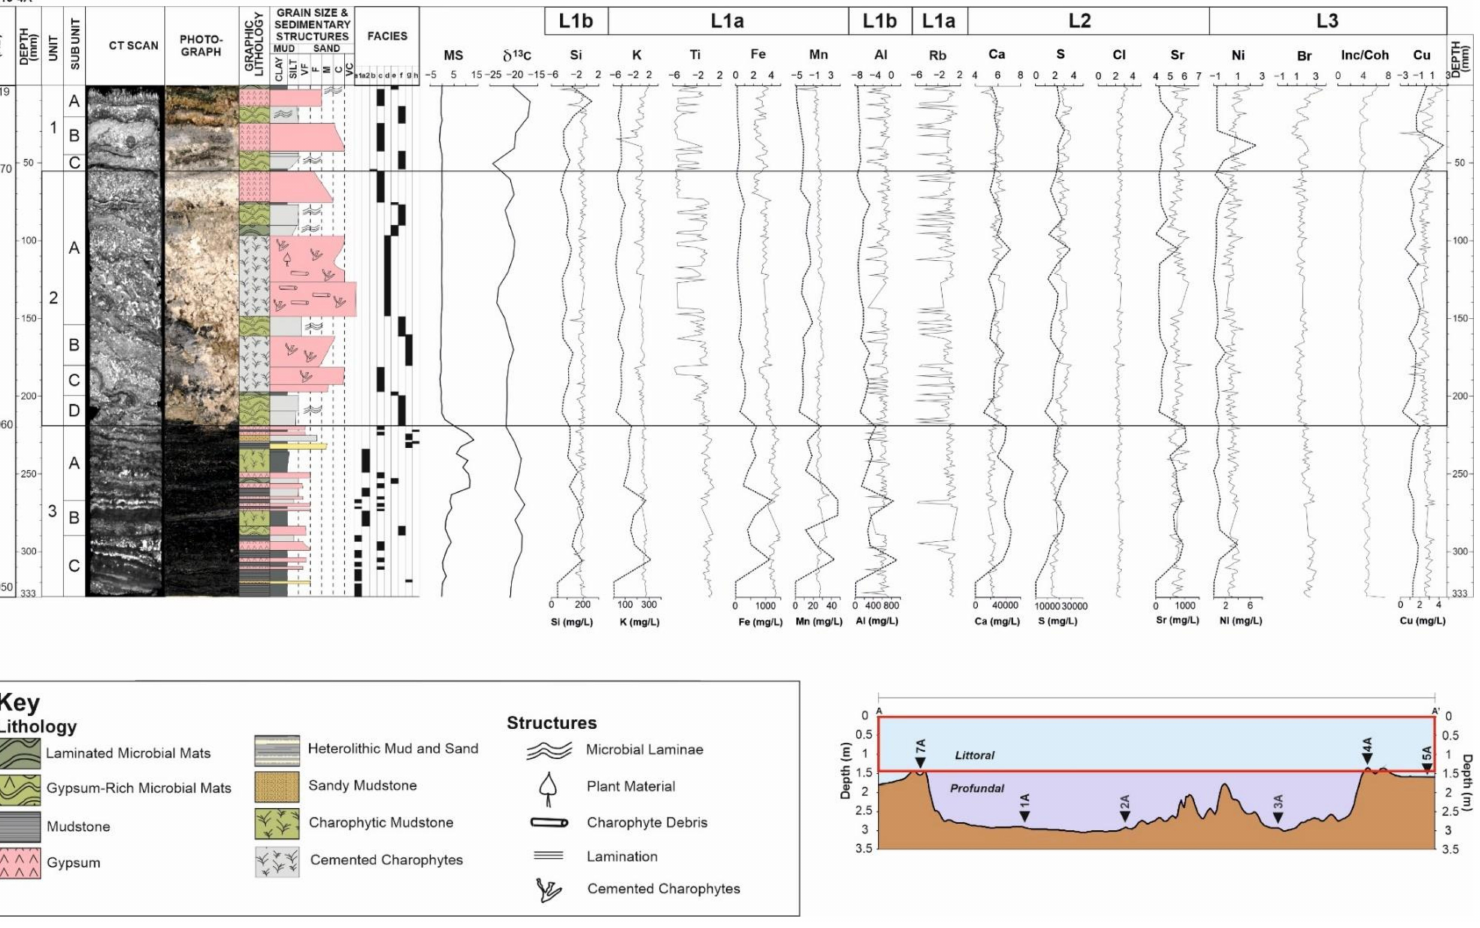
Figure 7. Figure illustrating a geochemical sequence of the littoral depositional sub-environment of Lake Chiprana (CHI19-4A), with elemental XRF data, expressed as counts per second and MS, expressed as SI, included. Elements are grouped according to the those shown on the associated PCA biplot in Figure 5. CT scans and high-resolution photographs are included alongside elemental data. CT data, photographs, lithology and facies are also defined in [30]. Element ICP data expressed as mg/L. Grey line = XRF, black line =